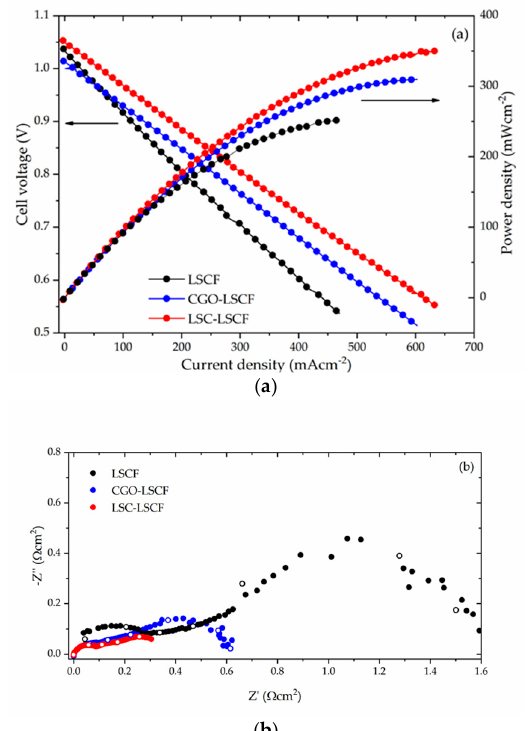
Figure 6. SEM cross-section images of the reference and the infiltrated samples after